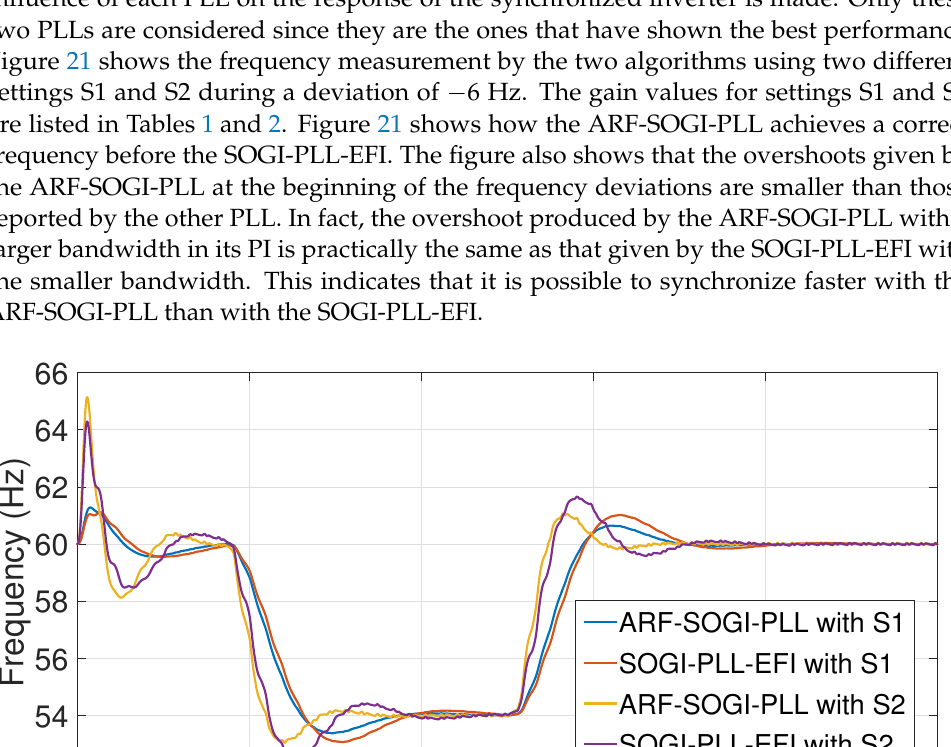
Figure 20. THD of the unit vectors β = sin